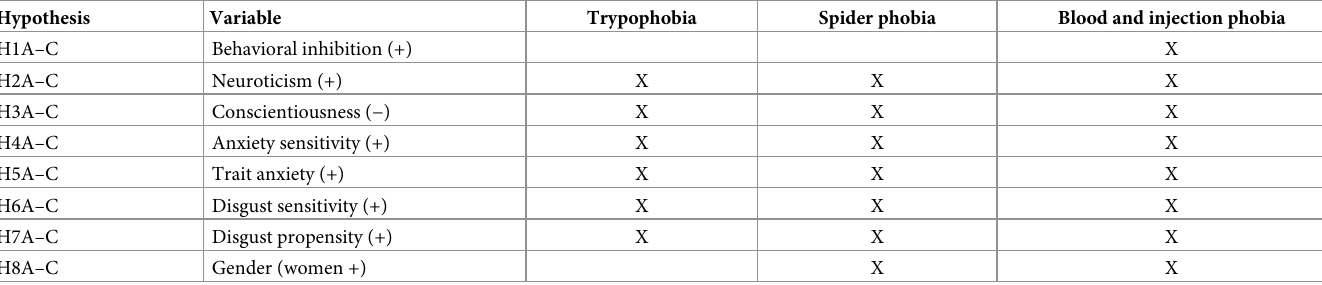
Table 4. Summary of the hypothesis